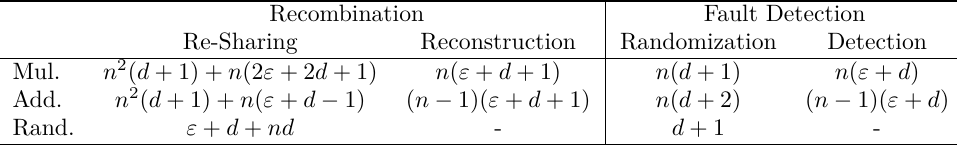
Table 3: Recombination Operation and Fault Detection Operation Recombination Fault Detection Re-Sharing Reconstruction Randomization Detection Mul.